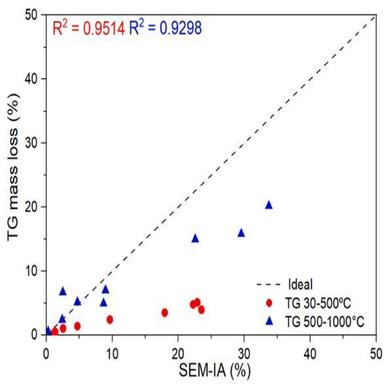
Correlation from SEM-IA cement paste content (red circle) and carbonates (blue triangle) with TGA mass losses at 30–500ºC and 500–1000ºC, respectively.